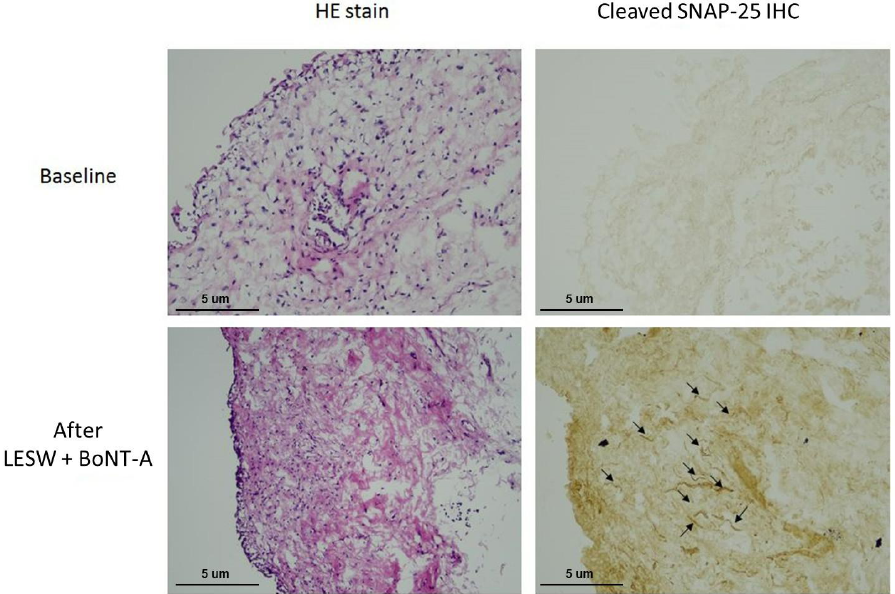
Figure 4. Immunochemical staining showing that the cleaved SNAP25 was not detectable in the bladder specimen before treatment ( upper ) but was evident at 1 month after LESW treatment with intravesical botulinum toxin A instillation ( lower